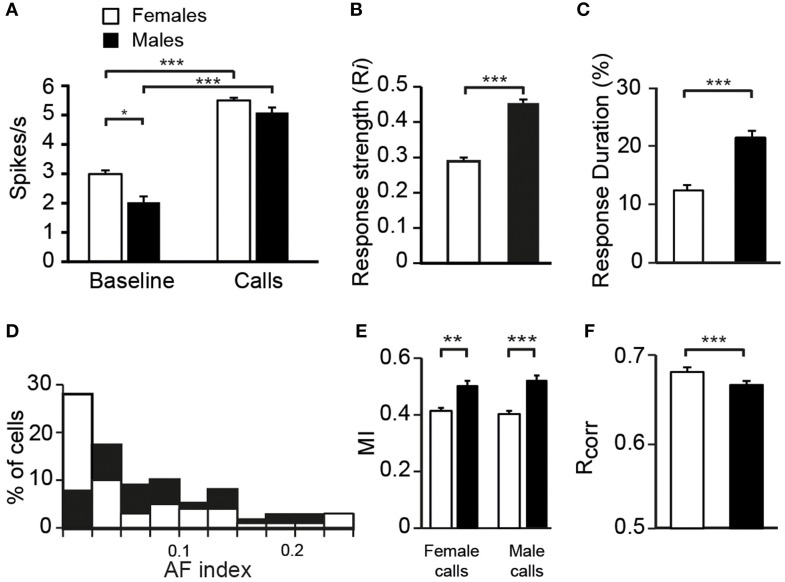
Differences between females and males in the response properties of neurons. (A) The average spontaneous firing rate (left) is higher in females than in males whereas the average call-evoked firing rate (right) did not differ between sexes. Both the average response strength (B) and response duration (C) are higher in males than in females. (D) The distribution of AF values for neurons recorded in males (black bars) and in females (white bars). The distribution of AF values are significantly different between sexes (χ2 = 3.13, p < 0.05). (E) The amount of mutual information (MI) transmitted in the patterns of responses to female or male calls is higher in males than in females. (F) The average values of the correlation index Rcorr for females and for males. Each bar represents the mean ± SEM (*p < 0.05; **p < 0.01; ***p < 0.001).